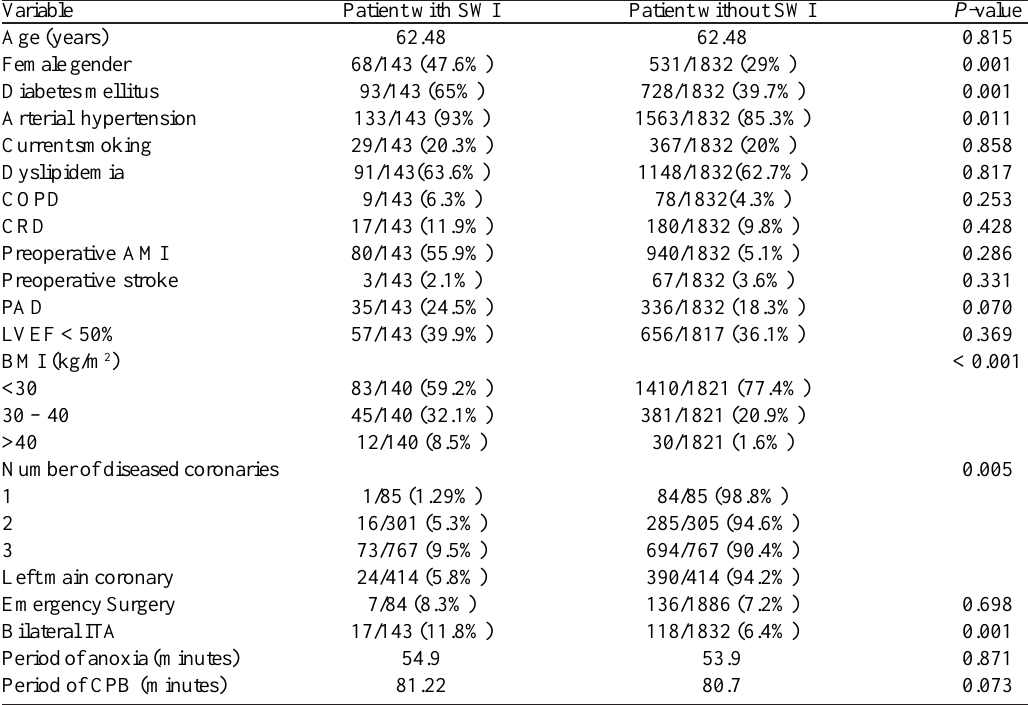
Table 1. Clinical characteristics and risk factors